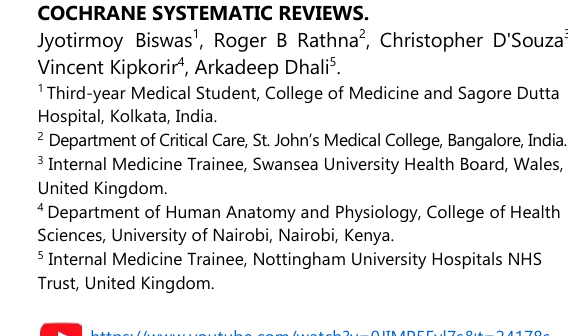
Figure . (A) Choropleth-style Map Demonstrating the Authorship Diversity Across Countries; (B) Gender Distribution in